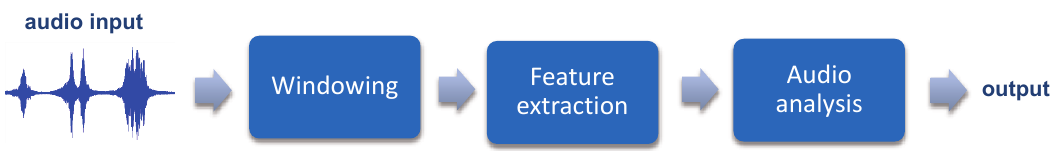
Figure 2. Generic architecture of a typical machine hearing